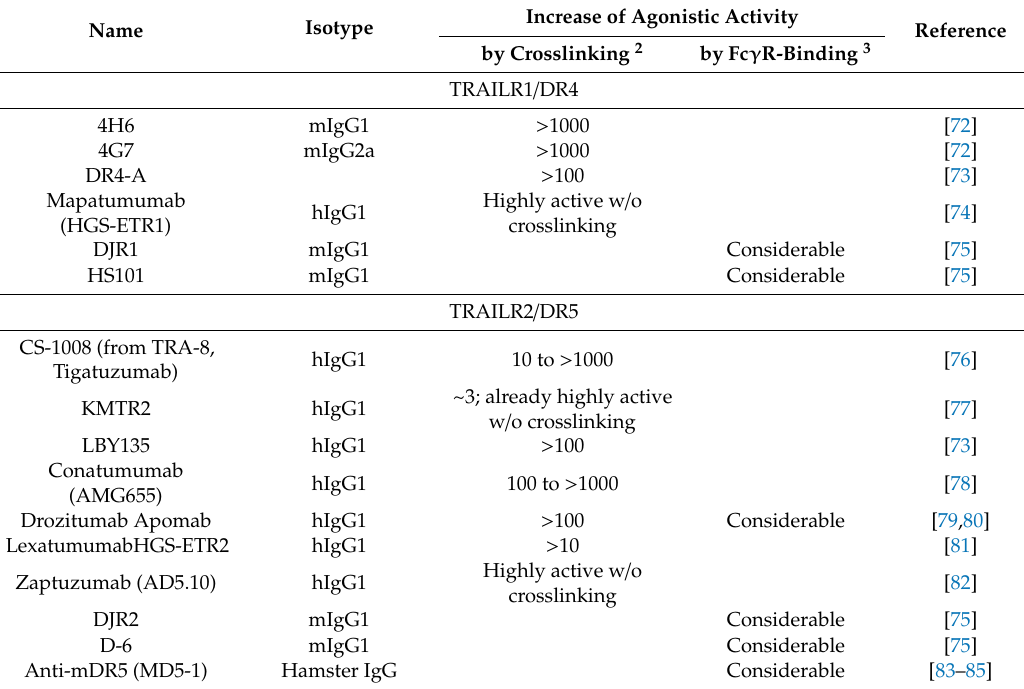
Table 2. TRAILR1- and TRAILR2-specific antibodies 1